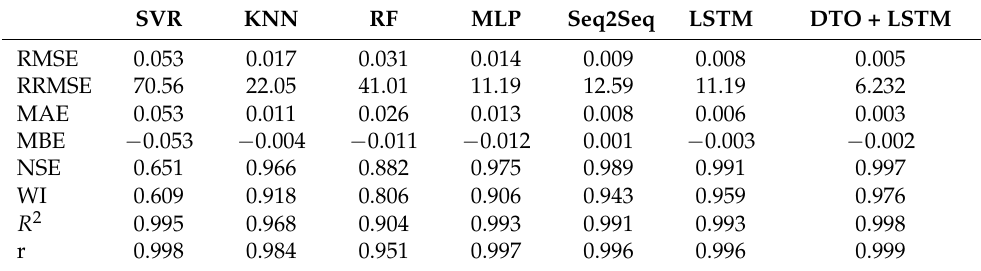
Table 4. Comparison between the proposed approach and other regression models based on the adopted evaluation criteria.